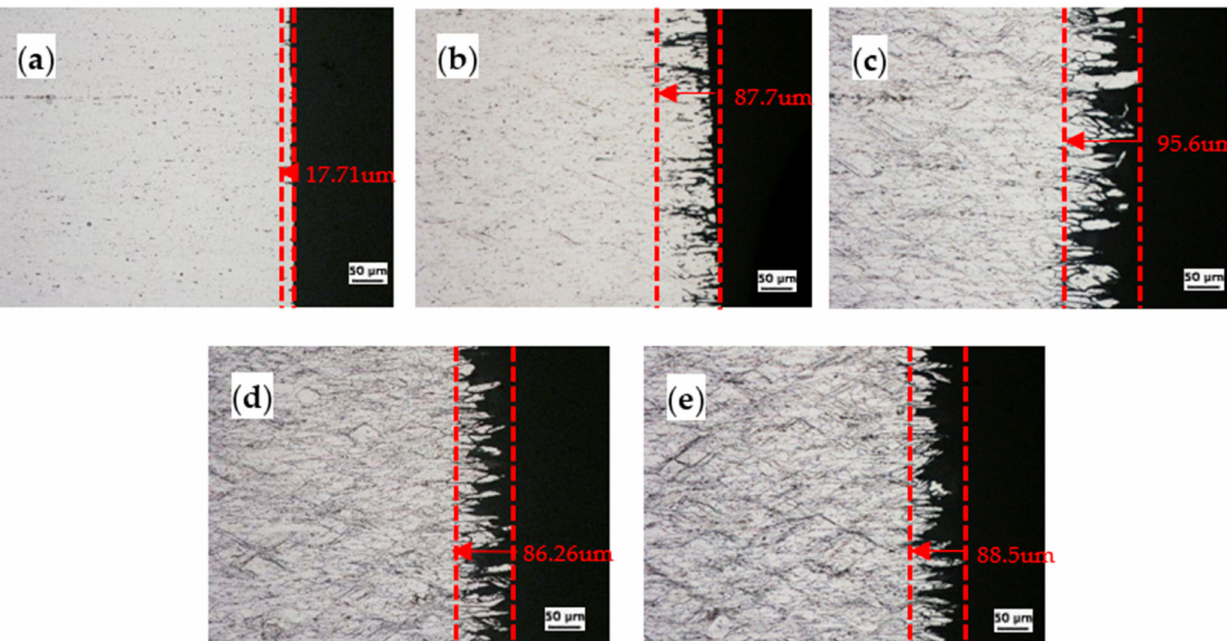
Figure 7. The surface of the CR50 alloy after NAMLT at different sensitization times: ( a ) 0 h, ( b ) 7 h, ( c ) 48 h, ( d ) 144 h, and ( e ) 207 h.